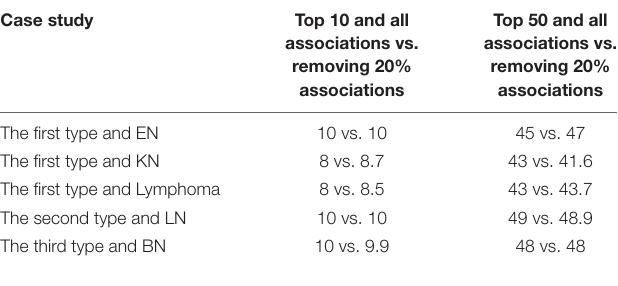
TABLE 7 | The number of validated miRNAs among top 10 and top 50 predicted miRNAs in case studies between with all known miRNA-disease associations and with removing 20%